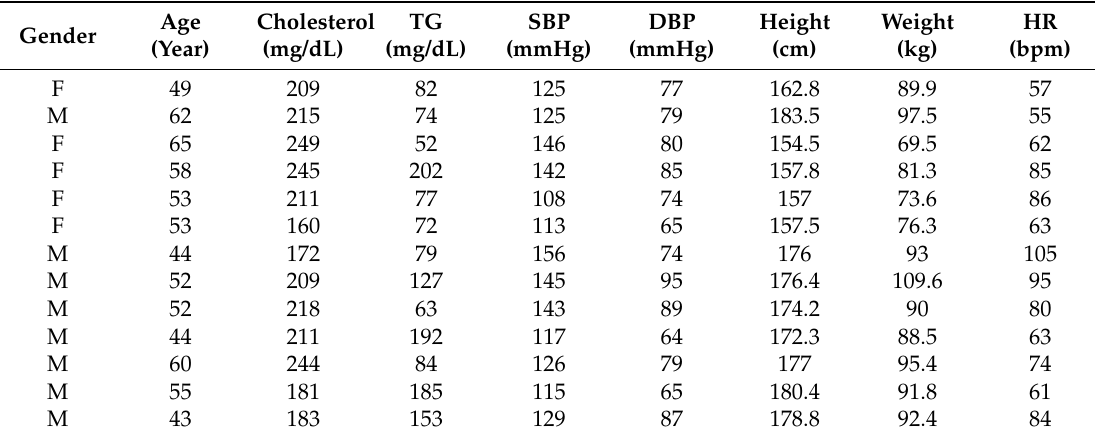
Table 2. Subject Characteristics ( n = 13).